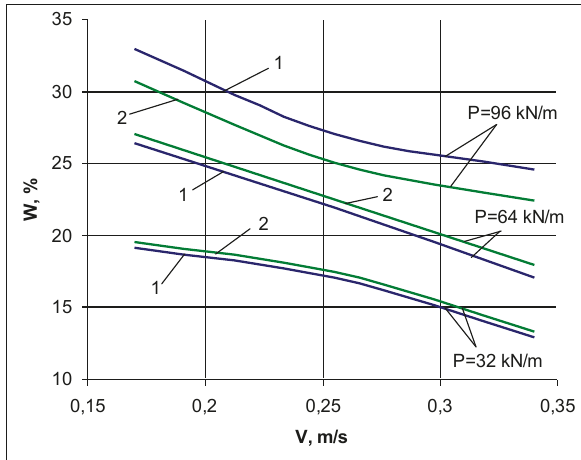
Figure 6. Dependence of the amount of removed moisture (W) on the feed rate (V) of the leather semi-finished product between compression rolls at an intensity of pressing force: P = 32 kN / m, P = 64 kN / m, P = 96 kN / m. 1—first layer of the leather semi-finished product; 2—second layer of the leather semi-finished product.